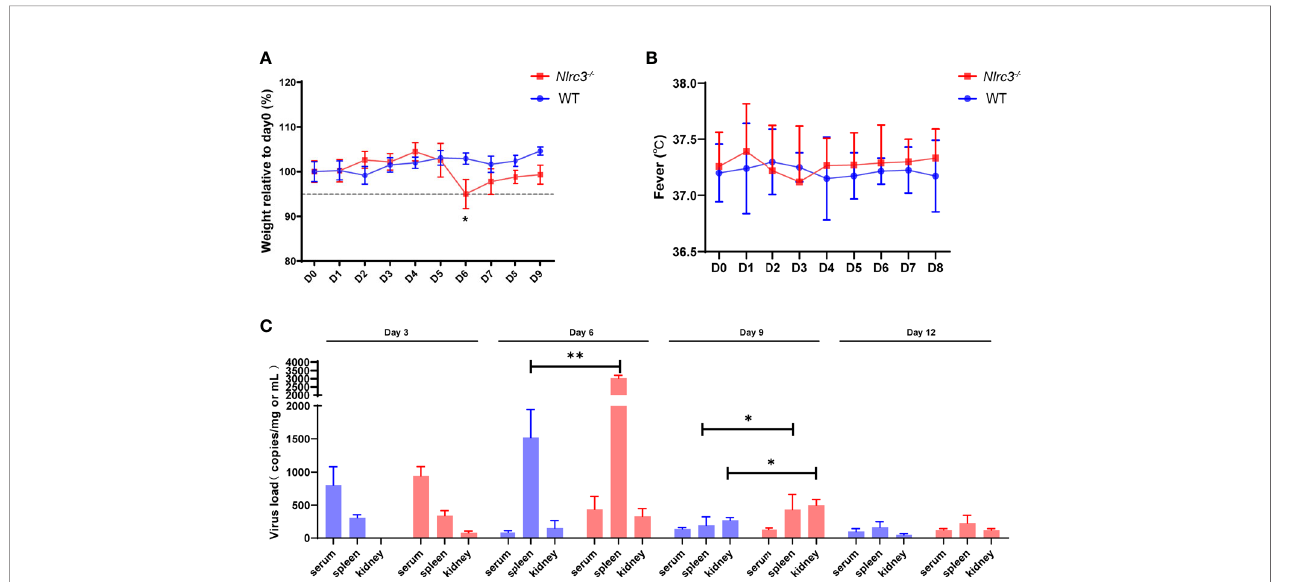
FIGURE 1 | Nlrc3 − / − mice are susceptible to HTNV infection. Mice were intraperitoneally inoculated with 5×10 5 PFUs of HTNV 76-118. (A) Body weights were recorded daily up to 9 dpi for Nlrc3 − / − mice (n=15) and C57BL/6J wild-type (WT) mice (n=10). At the time of inoculation (Day 0), the body weights of mice were set as the baseline, and weights relative to baseline were shown. (B) Body temperature was recorded daily up to day 8 post-infection for Nlrc3 − / − mice (n=25) and C57BL/6J wild-type (WT) mice (n=20). (C) Viral loads in the serum, spleen, and kidney of HTNV-infected mice were measured on 3, 6, 9, and 12 dpi ( Nlrc3 − / − mice, n=25, WT mice, n=20) by real-time PCR. The limit of detection (LOD) was indicated. Bars represented means ± SD. Asterisks indicate a signi fi cant difference in the quantity of viral RNA loads ( p <